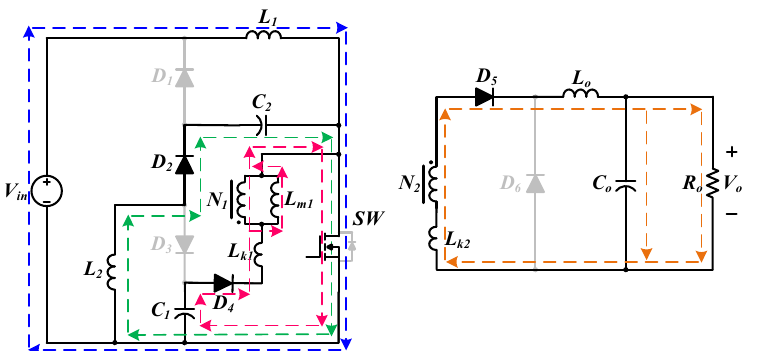
Figure 8. Equivalent circuit of the CHSDC in Mode 3.